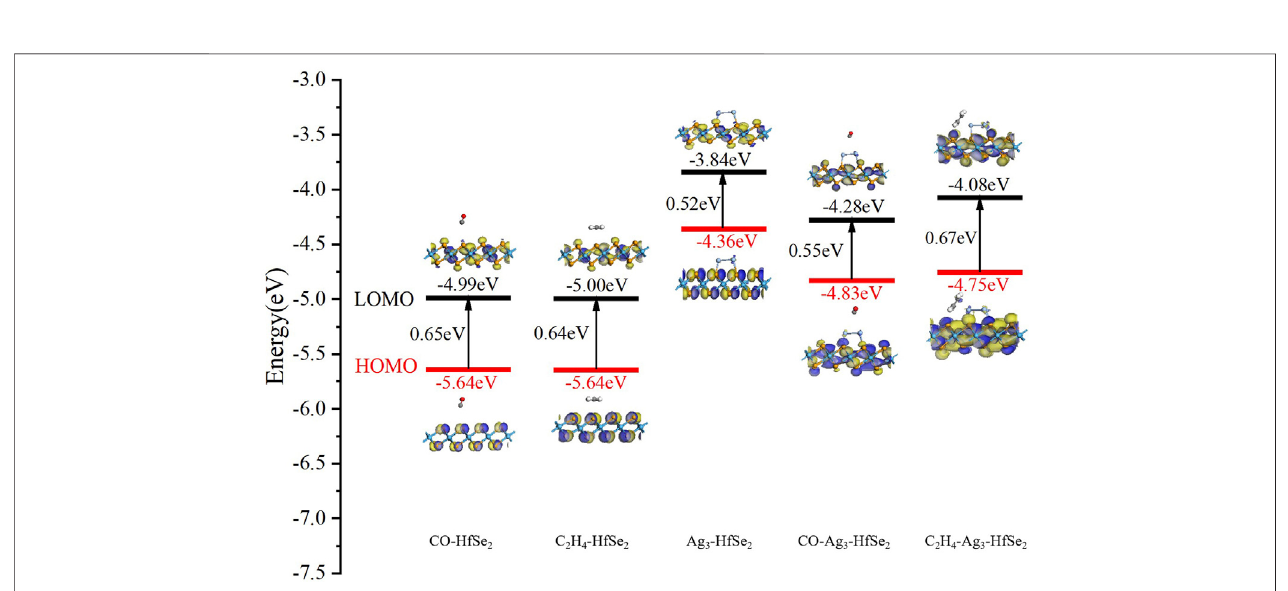
FIGURE 7 | Frontier molecular orbital distributions of CO and C 2 H 4 adsorption on pristine and Ag 3 – HfSe 2 monolayers, respectively.